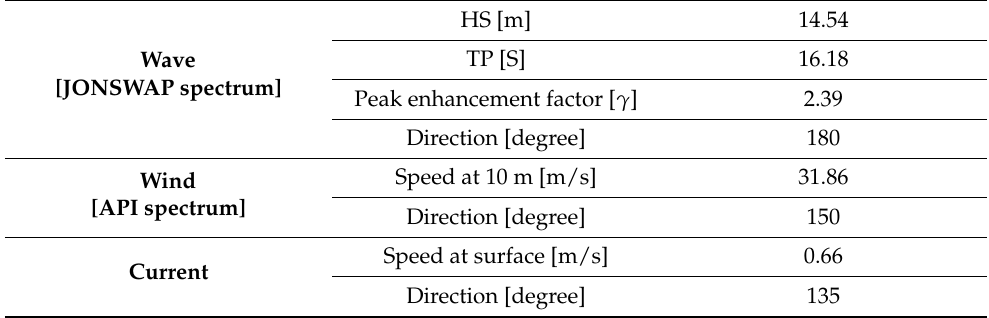
Table 4. Environmental conditions.